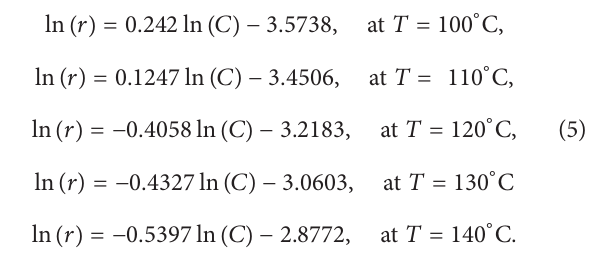
At curing 𝑇 = 130 ∘ C